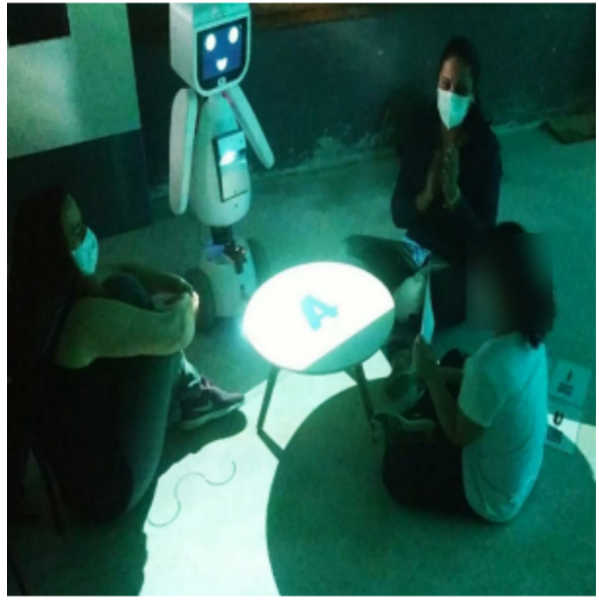
Figure 12. Girl interacting with the robot during the game “What is the Card?”.